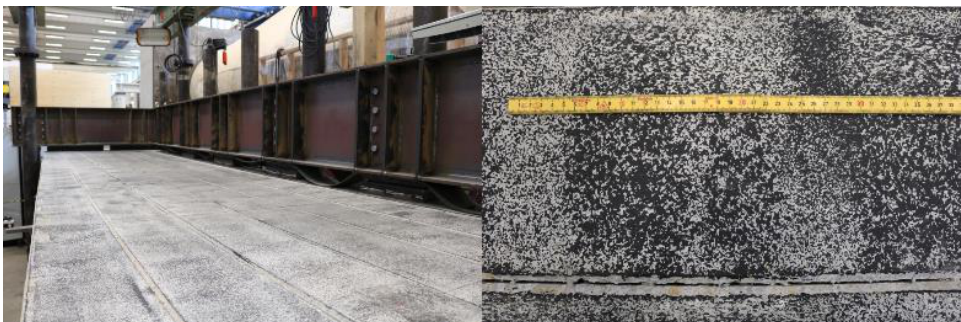
Figure 8. Contrast pattern on slab surface.